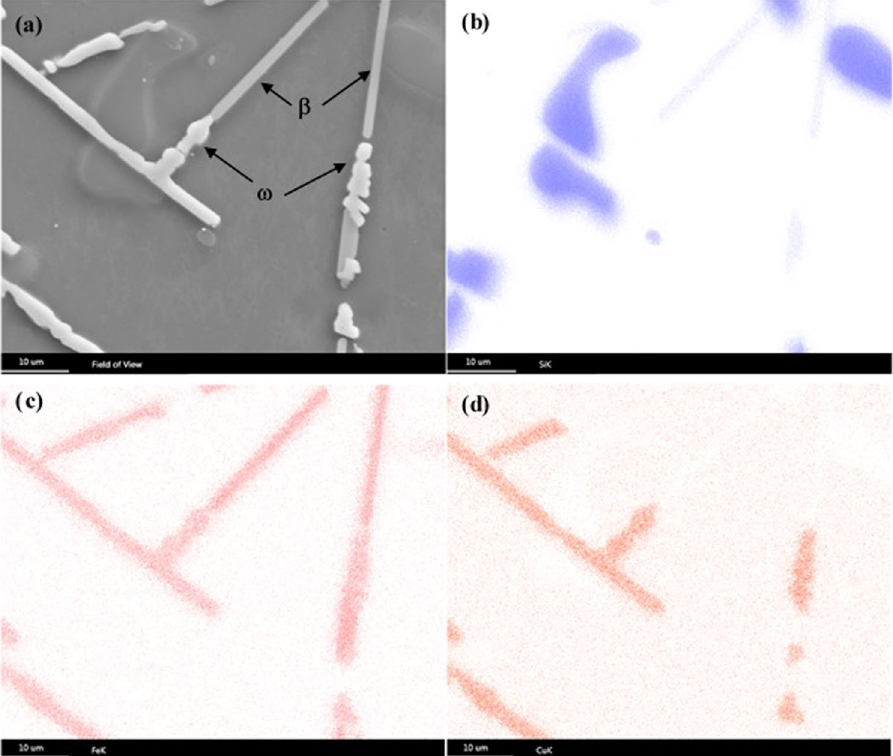
Figure 4. ( a ) SEM micrograph of 6Cu sample solutionized at 793 K for 684 ks and ( b – d ) corresponding x-ray elemental mapping (with EDS) using, ( b ) Si-K α , ( c ) Fe-K α and ( d ) Cu-K α . Si, Al 9 Fe 2 Si 2 ( β ) and Al 7 Cu 2 Fe ( ω ) phases were identified along with Al-matrix but Al 2 Cu ( θ ) phase was not observed in the microstructure.